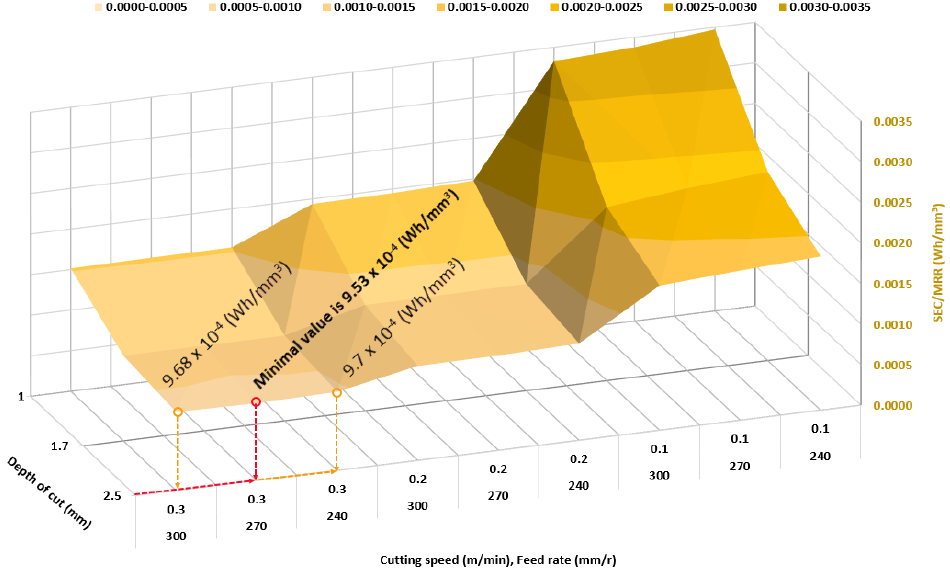
Figure 12. Specific energy consumption (SEC) as a ratio of time-specific total energy consumption per material volume removal rate (mm 3 /s) in relation to the selected range of a p , f , v c .